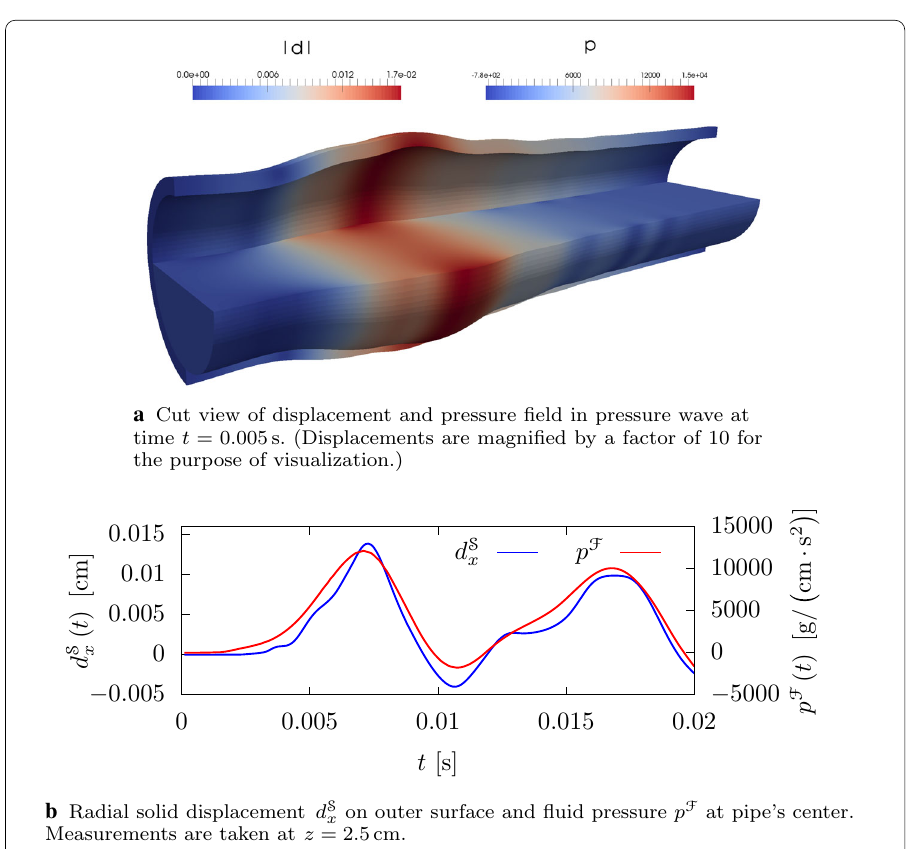
Fig. 4 Solid displacement and fluid pressure in the pressure wave